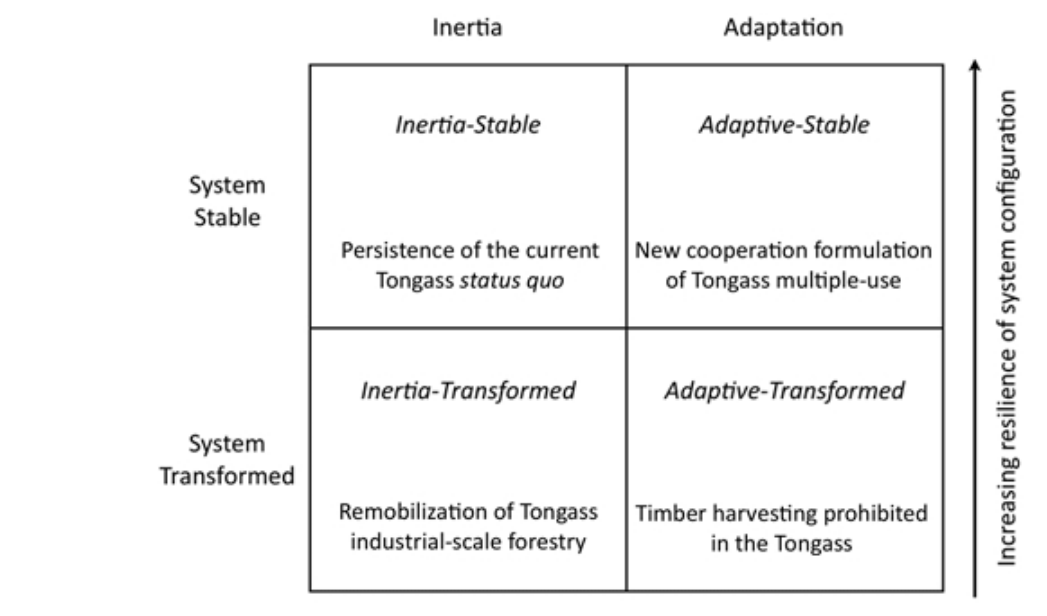
Fig. 9 . Four generalized system reorganization scenarios, based on drivers (inertia vs. adaptation) and dynamics (stable vs. transformed) of Tongass National Forest